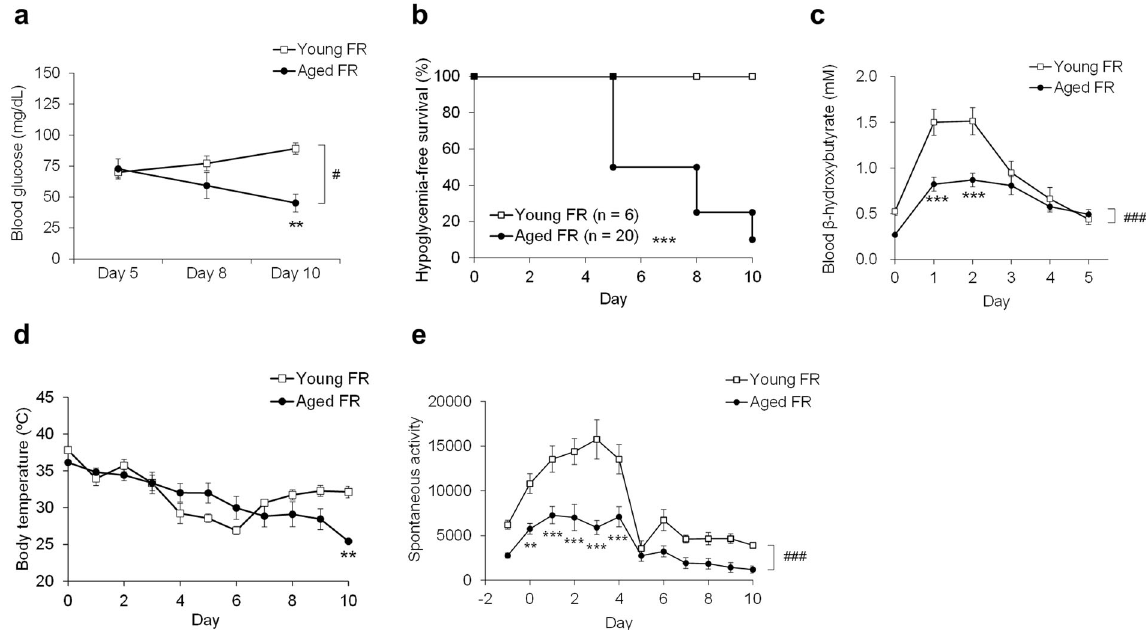
Fig. 1 Biochemical and physiological changes on food restriction. a Fasting blood glucose levels in young ( n = 6) and aged mice ( n = 7 – 14) on days 5, 8, and 10 after daily food restriction (FR). Two-way ANOVA revealed a signi fi cant effect of age (#; F (1, 43) = 6.98, P = 0.0115) and age × time interaction ( F (2, 43) = 3.23, P = 0.0495); ** P < 0.01 vs. young FR mice at this time point by Bonferroni test. b Hypoglycemia-free survival; hypoglycemia is de fi ned as blood glucose level <50 mg/dL; *** P < 0.001 vs. young FR mice by log-rank test. c Fasting blood β -hydroxybutyrate ( β HB) levels in mice on daily FR. Two-way ANOVA revealed signi fi cant effects of age (###; F (1, 113) = 32.8, P < 0.001), time ( F (5, 113) = 30.6, P < 0.001), and the age × time interaction ( F (5, 113) = 5.87, P < 0.001); *** P < 0.001 aged FR mice ( n = 12 – 13) vs. young FR mice ( n = 8) at each time point by Bonferroni test. d Body temperature before feeding. Two-way ANOVA revealed signi fi cant effects of time ( F (10, 206) = 10, P < 0.001) and age × time interaction ( F (10, 206) = 2.8, P = 0.0029). ** P < 0.01 aged FR mice ( n = 8 – 20) vs. young FR mice ( n = 6) at this time point by Bonferroni test. e Daily spontaneous activity. Two-way ANOVA revealed signi fi cant effects of age (###; F (1, 226) = 112, P < 0.001), time ( F (11, 226) = 23.1, P < 0.001), and the age × time interaction ( F (11, 226) = 3.17, P < 0.001), ** P < 0.01, *** P < 0.001 aged FR mice ( n = 7 – 13) vs. young FR mice ( n = 10) at each time point by Bonferroni test. Data are presented as mean ± SEM ( a , c , d , and e